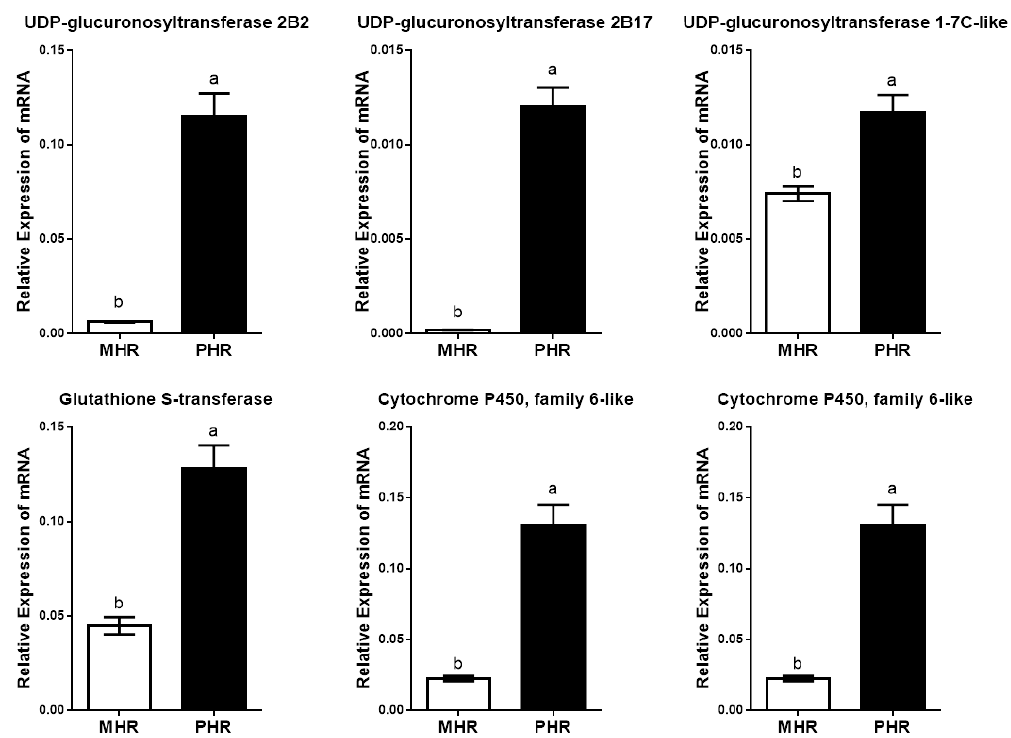
Figure 5. Expression levels of six candidate genes between the two host races of Acyrthosiphon Pisum on Medicago sativa . Different lowercase letters indicate significant differences between the Medicago host race (MHR) and the Pisum host race (PHR), as determined by Student’s t -test at p < 0.05.